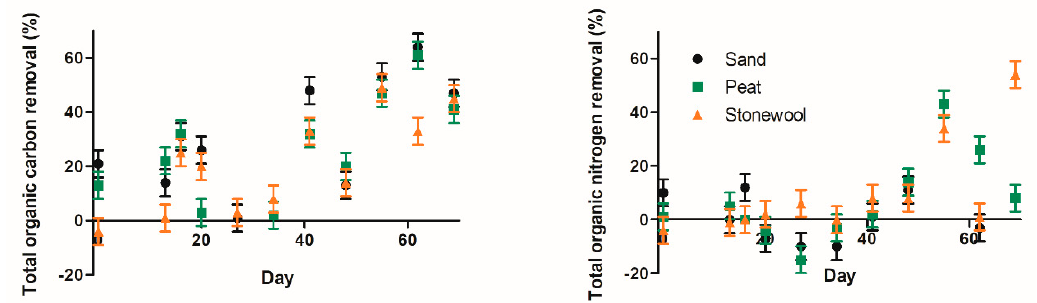
Figure 1. Removal of total organic carbon and nitrogen (%) in the three biofilters. Inflow concentrations during NH 4 Ac-pulses were adjusted to theoretical input. Data points below − 20% were for simplicity removed from the plot (sand; day 55 and 69) and error bars were set to ±5%.